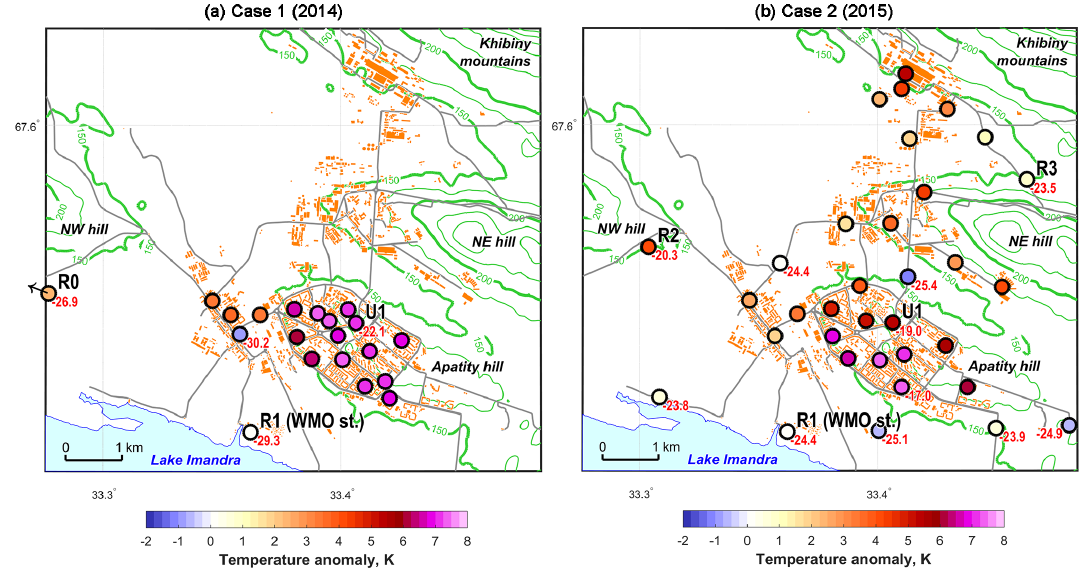
Figure 5. Spatial patterns of the air temperature anomalies at each station with respect to the temperature at the R1 station. The anomalies were averaged over 3h time intervals which included the maximum temperature anomaly during the observation periods in (a) 2014 (Case 1 from Fig. 3) and (b) 2015 (Case 2). The color scales show the magnitude of the temperature anomaly. The red numbers indicate the absolute temperatures in ◦ C. The temperatures were measured at a height of 2m above the ground, i.e., they correspond to significantly different elevations above sea level. The surface elevation is shown by the green contour lines (drawn every 25m), and the 150 and 200m contour lines are shown in